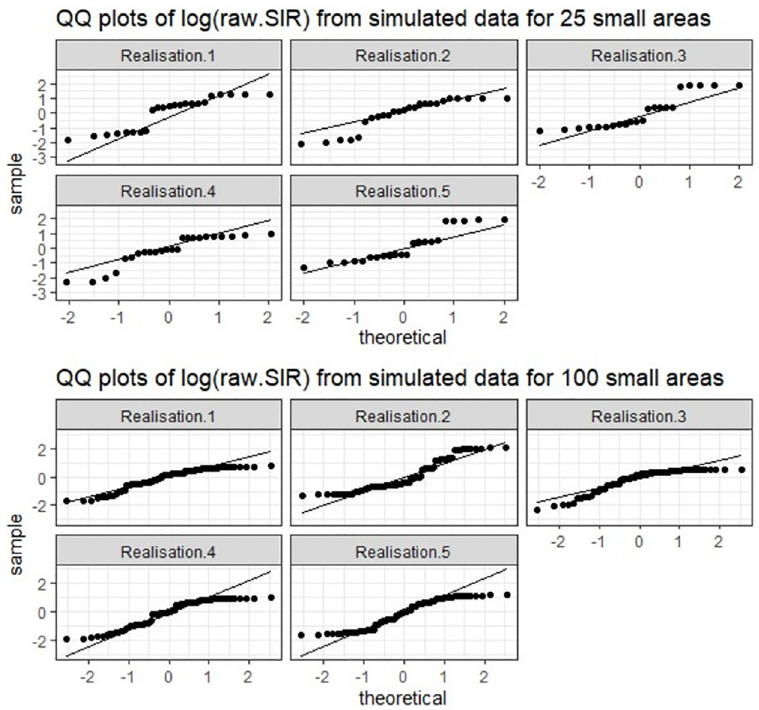
Fig 5. The observed response variable (y = log(SIR)) from simulated response under high autocorrelation (5 realisations for each of 25 areas and 100 areas).